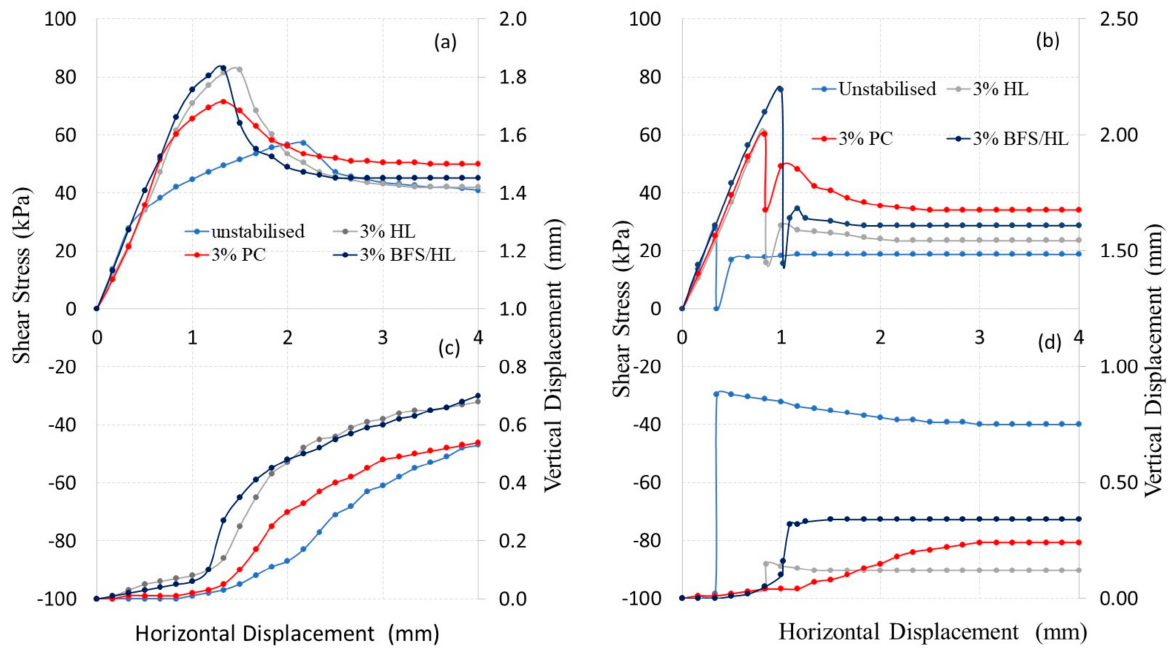
Figure 7. Summary of the shear box tests ( a , c ) as-compacted condition and ( b , d ) inundation at yield.